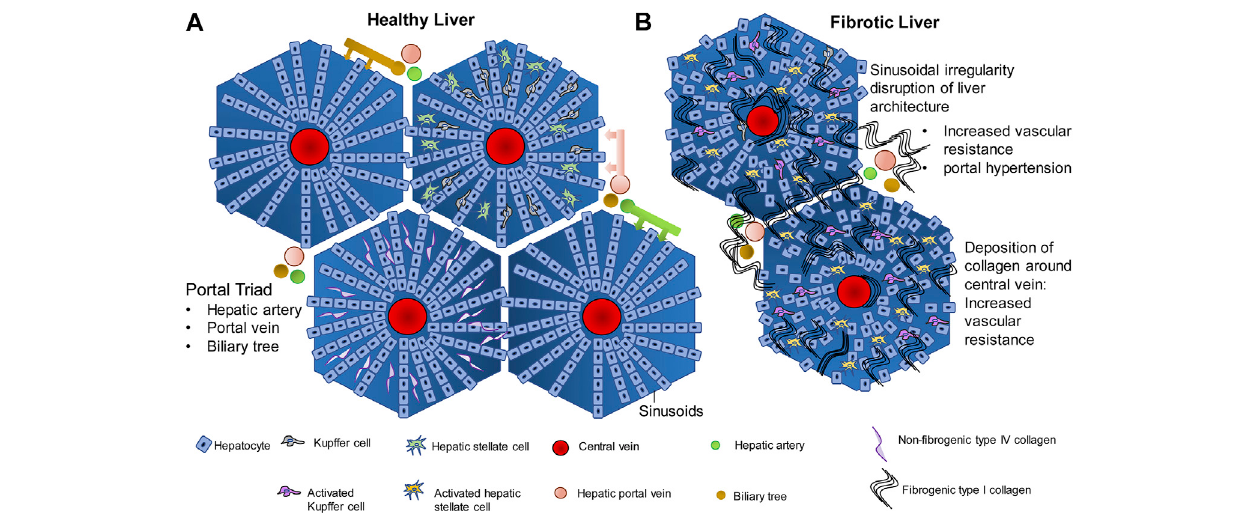
FIGURE 1 | Liver architecture in healthy liver and fi brosis. (A) In normal liver, hepatocytes are arranged in rows radiating outwards from the central vein, toward the edge of the lobule. The gaps between the hepatocyte rows are known assinusoidswhich arelined with endothelial cells, and contain Kupffer cells, hepatic stellate cells, andcontainextracellularmaterialsuchasthenon fi brogenictypeIVcollagen.Hepaticportalvein,hepaticarteryandbiliarytreearethethreemajorvesselsfeedingintothe sinusoidsand theexchangeofblood gases, nutrients and other signaling molecules occurs in thesinusoids. (B) Injury tohepatocytes due toany ofseveral causes such as alcohol, drug, genetic predisposition, etc., activates the wound healing fi brogenic response. Chronic injury to the hepatocytes and chronic activation of the fi brogenic pathway in the liver leads to synthesis of fi brogenic type I collagen by the Hepatic stellate cells and its deposition within the sinusoids. Deposition around the central vein and around the portal vein leads to increase in vascular resistance and portal hypertension. Compensatory mechanisms such as esophageal varices and ascites